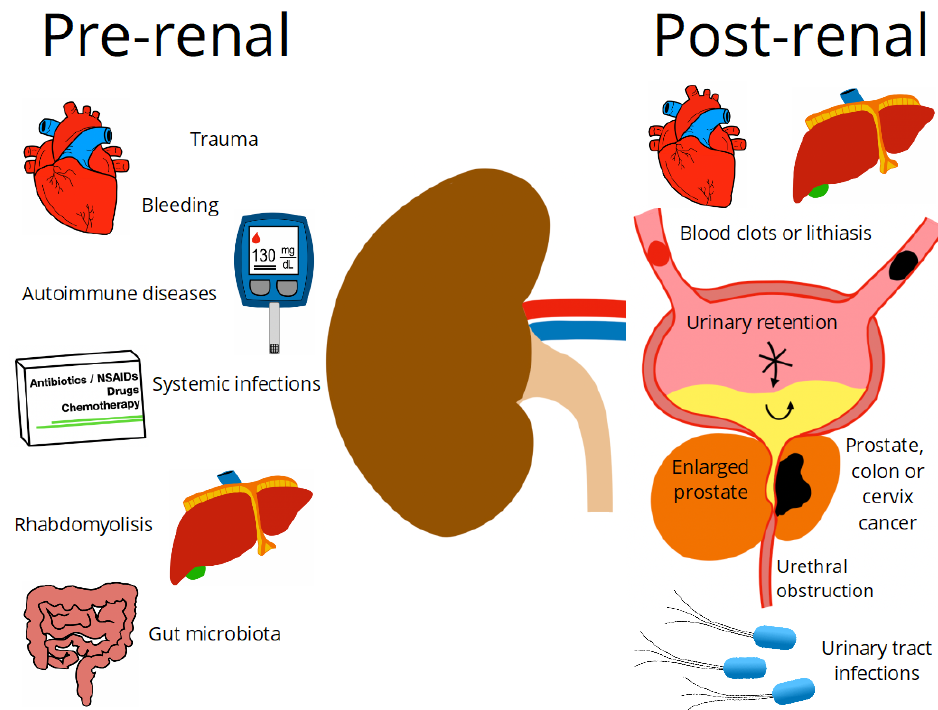
Figure 1. Pre-renal and post-renal diseases.